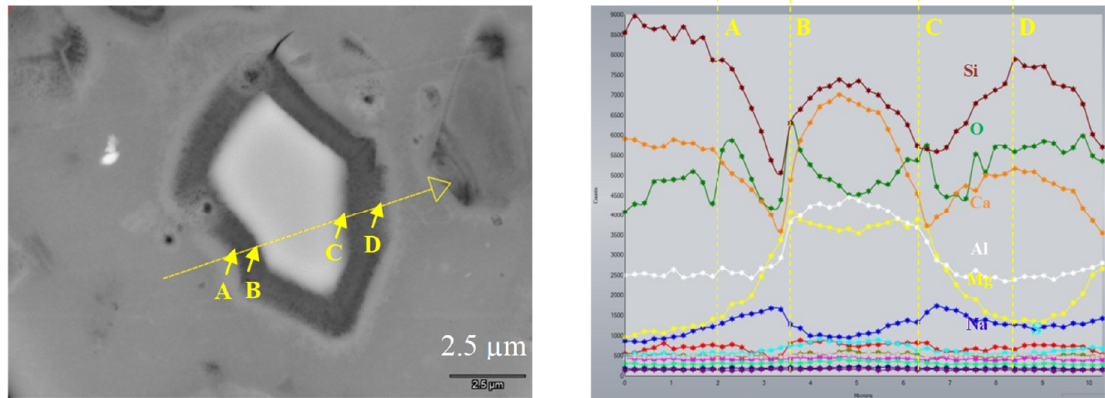
Figure 16. The BSE image of the microstructure around a reacted GBFS particle of the paste S100 after 1 year of reaction ( left ) and corresponding EDX linescan-profiles along the yellow arrow for the constituent elements (Si, O, Ca, Al, Mg, Na) ( right ).